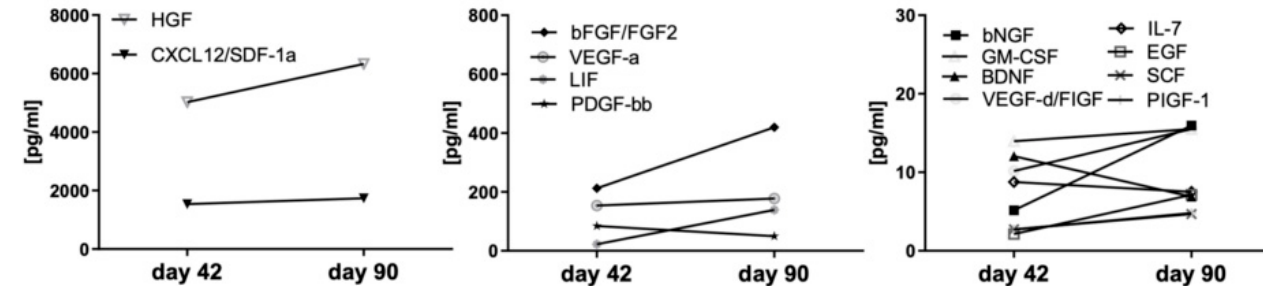
Figure 5. Stable pro-fibrotic growth factors in the liver of an infant undergoing Re-KPE. Legend: One infant underwent a first KPE at day 42 but had to undergo a Re-KPE at day 90. The protein microenvironment in the liver was assessed at both time points.